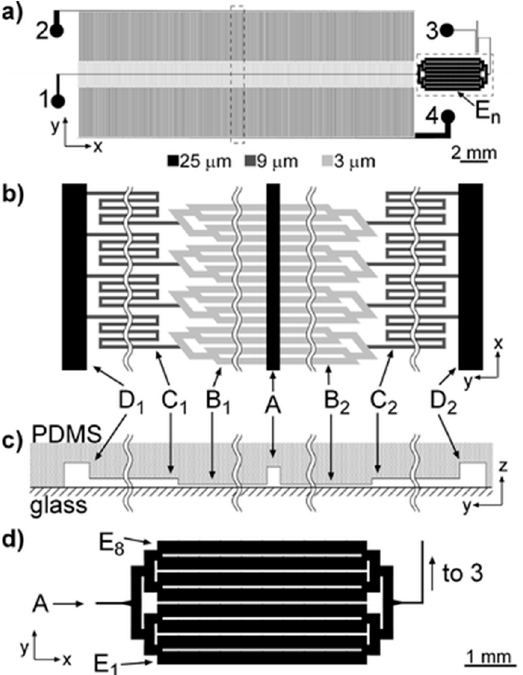
Figure 5. ( a ) Drawing of the microfluidic device, ports labeled 1–4 are blood inlet, perfusion inlet, WBC outlet, and RBC outlet, respectively; ( b ) blowup of a fragment of the separation network outlined with a dotted line in ( a ) turned counterclockwise by 90° with respect to ( a ); ( c ) cross-sectional view of channels in the separation network, dimensions are not to scale; ( d ) blowup of E channels outlined with a dotted line in ( a ). Channel depths, 25, 9, and 3 μ m, are grayscale coded in ( a , b , d ). The figure has been reproduced with permission from the American Chemical Society [151].